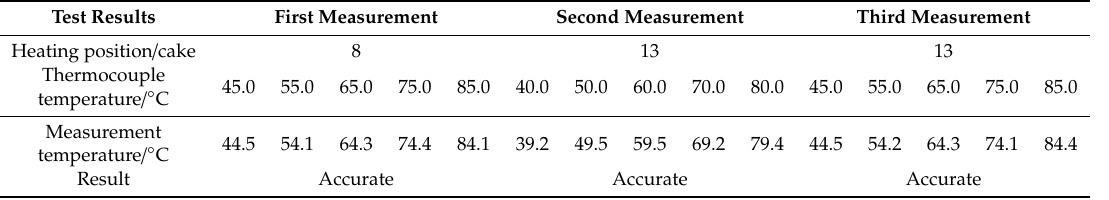
Table 6. Comparison of winding hot-spot temperature measurement